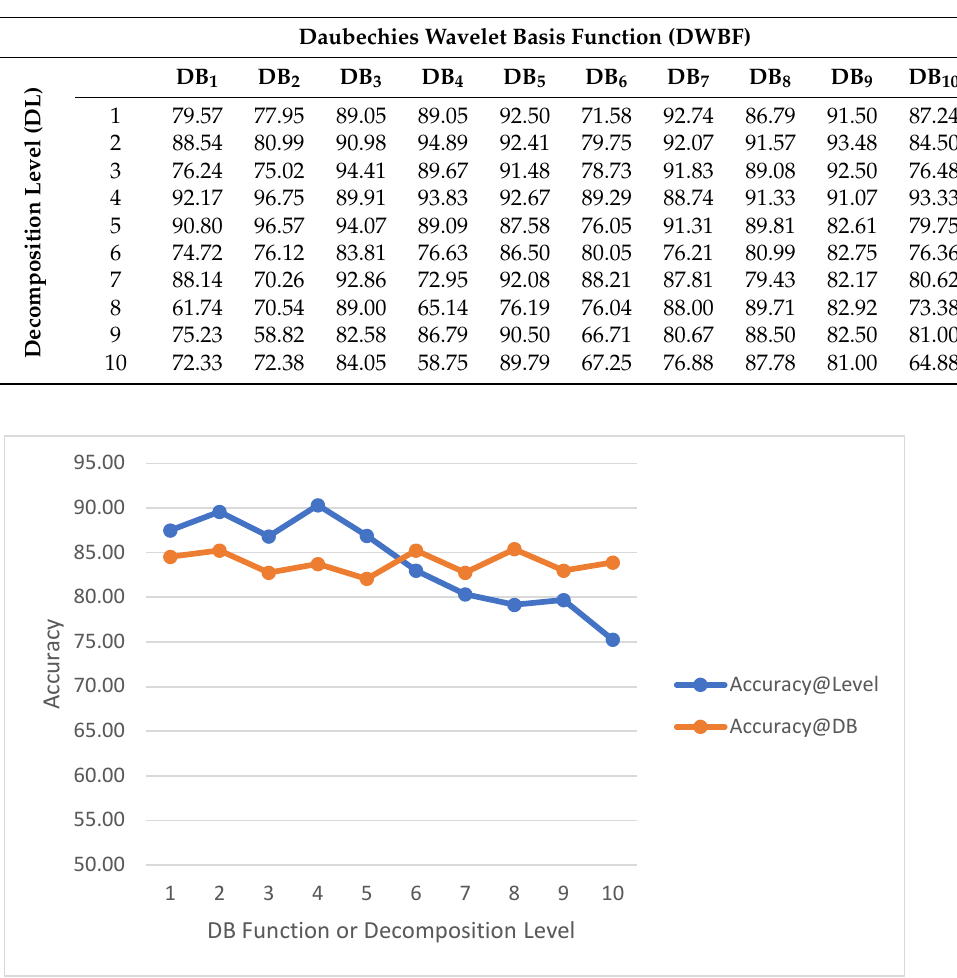
Table 6. Average sensitivity (%) due to DWBF and decomposition level (DL). Daubechies Wavelet Basis Function (DWBF) D e c o m p o s iti o n L e v e l ( D L )